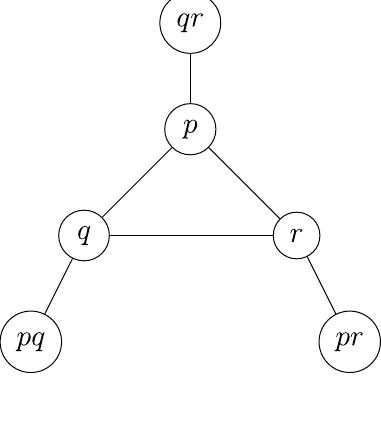
Figure 1: H for n pqr =